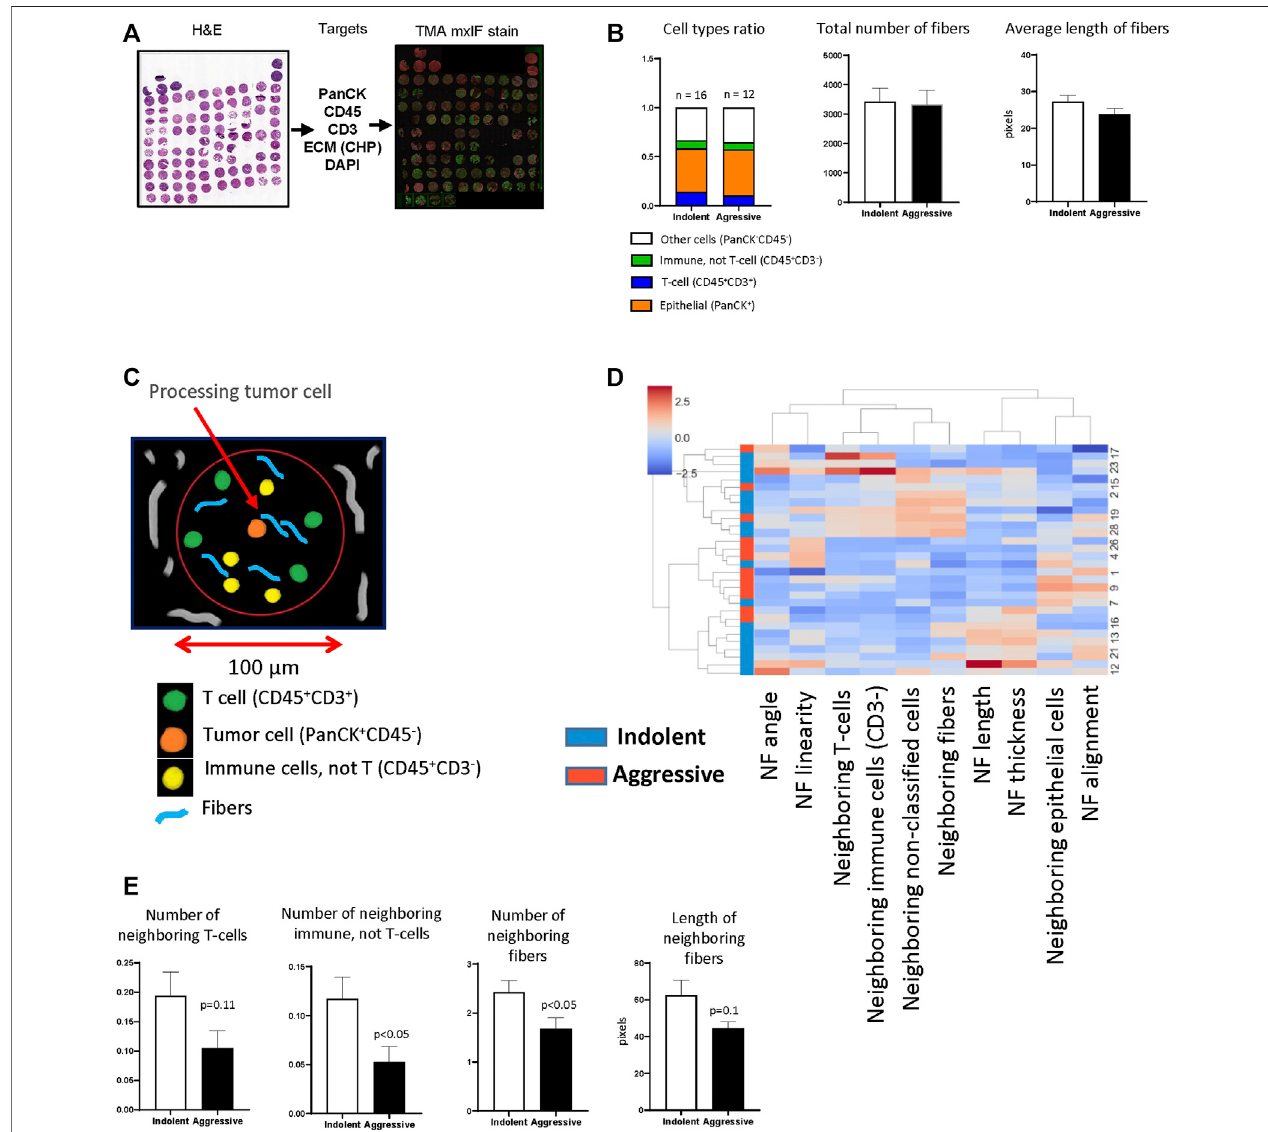
FIGURE 4 | TMA analysis. (A) TMA was generated from lung tissue blocks from patients with lung adenocarcinoma as described. Two tissue cores were used to represent one patient. Fluorescent staining was performed for PanCK, CD45, CD3, DAPI. (B) The analysis of basic features of tumor tissue. (C) Diagram demonstrates principle of implemented spatial analysis. Tumor cells were used as processing objects, neighborhood outline was equal to 100 μ m, all cells and fi bers within the neighborhoodoutlinewerecountedandanalyzed. (D) Hierarchicalclusteranalysisbasedonspatialfeaturesoftumorcells(NF – neighboring fi bers). (E) Comparison of spatial features of tumor cells in indolent and aggressive